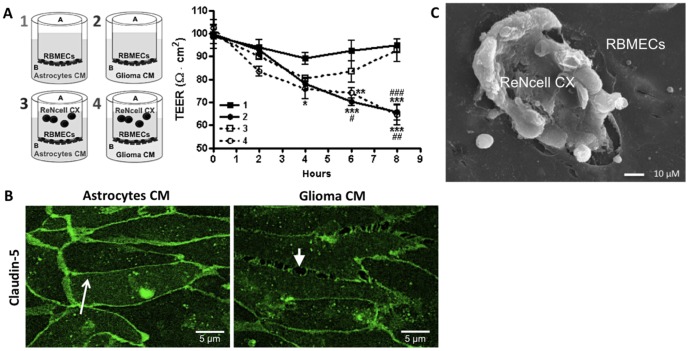
Glioma C6 CM opens the BBB of RBMECs.A) TEER of RBMECs in the conditions illustrated in the scheme. N = 3, F(3,30) = 19.97;
*P<0.05, **P<0.01, ***P<0.001, with respect to 1; #P<0.05,
##P<0.01, ###P<0.001, with respect to 3; as assessed by two-way ANOVA
followed by Bonferroni's post hoc test. B) Immunofluorescence localization of claudin-5 and occludin
in RBMECs incubated with astrocytes or glioma C6 CM. Arrow, continuous cell border staining;
arrowheads, holes appearing at cell borders. C) Scanning electron micrograph of ReNcells CX moving
across a hole in the endothelial monolayer.